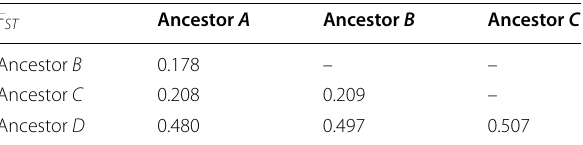
Table 3 F ST divergences between ancestry populations inferred by